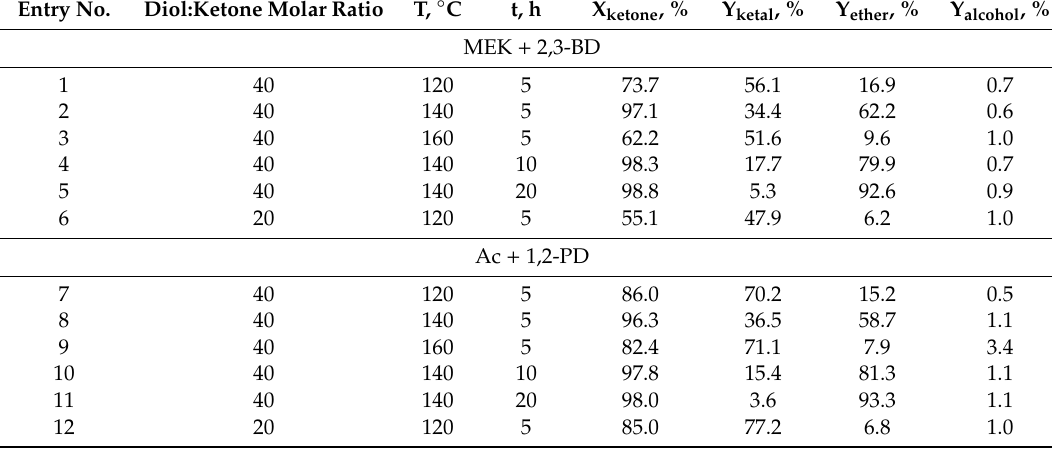
Table 5. The reductive alkylation of 1,2-PD and 2,3-BD with acetone and MEK with 2%Pd /